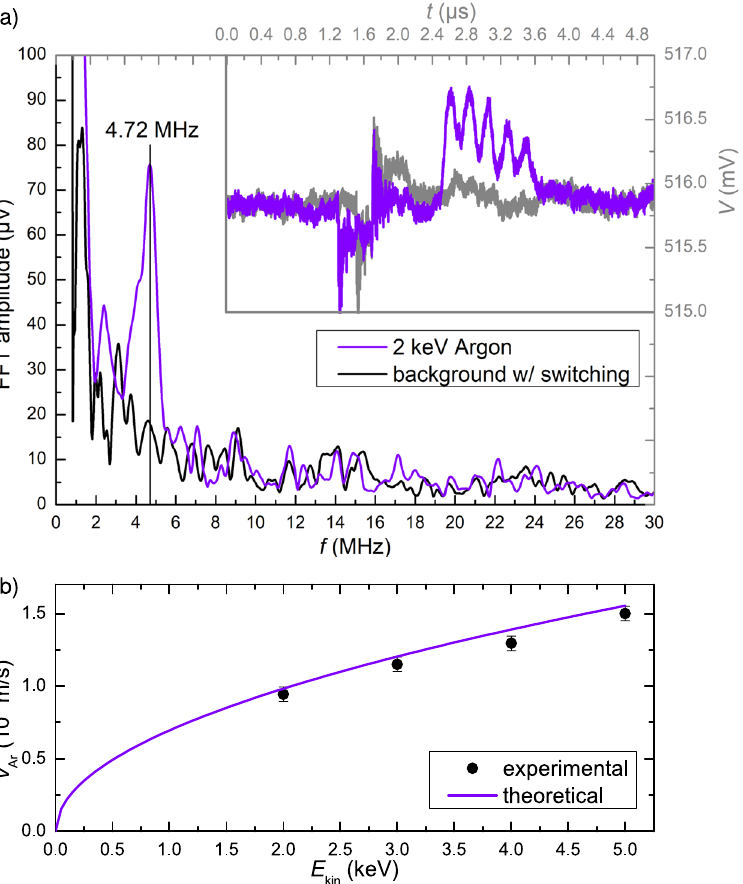
Figure 5. Fourier analysis of time signals recorded with five signal electrodes (ICD2.5). (a) Time signal (upper right, blue line, grey scale) and its FFT spectrum (bottom left, blue line, black scale) for 2 keV Argon ion bunches, shown together with the background spectrum (black/grey line) without ion bunch, but including switching interference, averaged over 100 acquisitions. (b) Ion velocity calculated from experimental FFT spectra for Argon ions with m = 40 u and 20 mm periodic length, dependent on ion beam energy and theoretical curve from = v